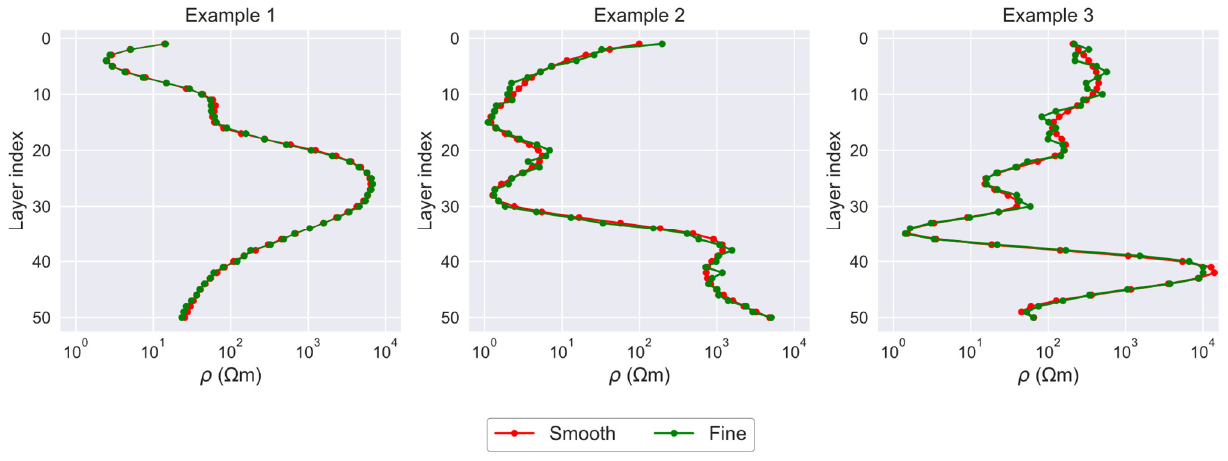
Figure 4. Three representative examples of comparison between the general smooth and the pro- posed fine resistivity models. The fine resistivity models are evolved from the smooth resistivity models.